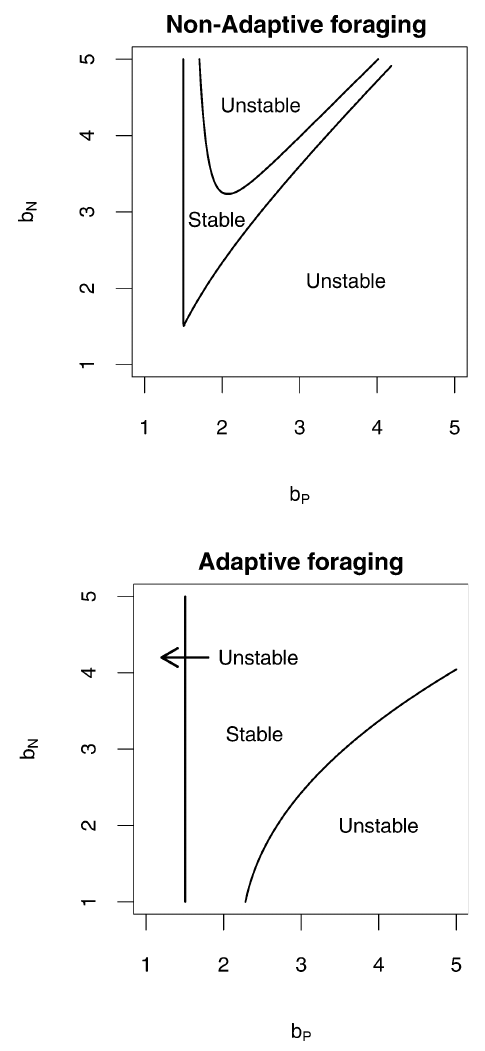
Fig. 3. An example of parameters (b nity stability. r = 1, K = 1, A